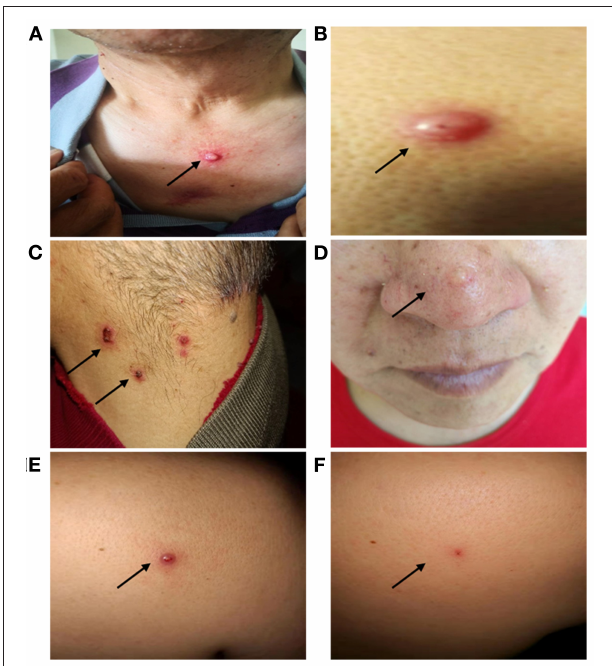
FIGURE 3 | Immunohistochemistry of a sebaceous gland adenoma. (A) Hematoxylin and Eosin, 20x; (B) MLH1, 100x; (C) PMS2, 100x; (D) MSH2, 100x; (E) MSH6,